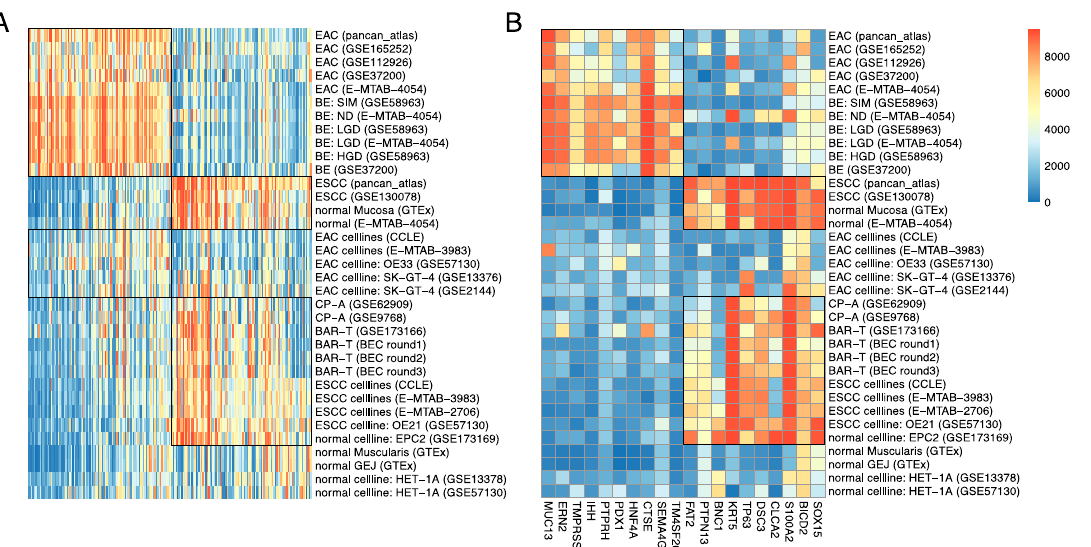
Figure 6. Expression pattern of individual EAC hi and ESCC hi genes in various tumor and normal tissues and cell lines. ( A ) Median expression (rank normalized) of the 100 EAC hi genes and the 100 ESCC hi genes in various tumor and normal tissues and cell lines used in the entire manuscript. ( B ) Median expression (rank normalized) of the top 10 genes (each) for EAC and ESCC in various tumor and normal tissues and cell lines from available datasets. Red = high expression and blue = low expression.